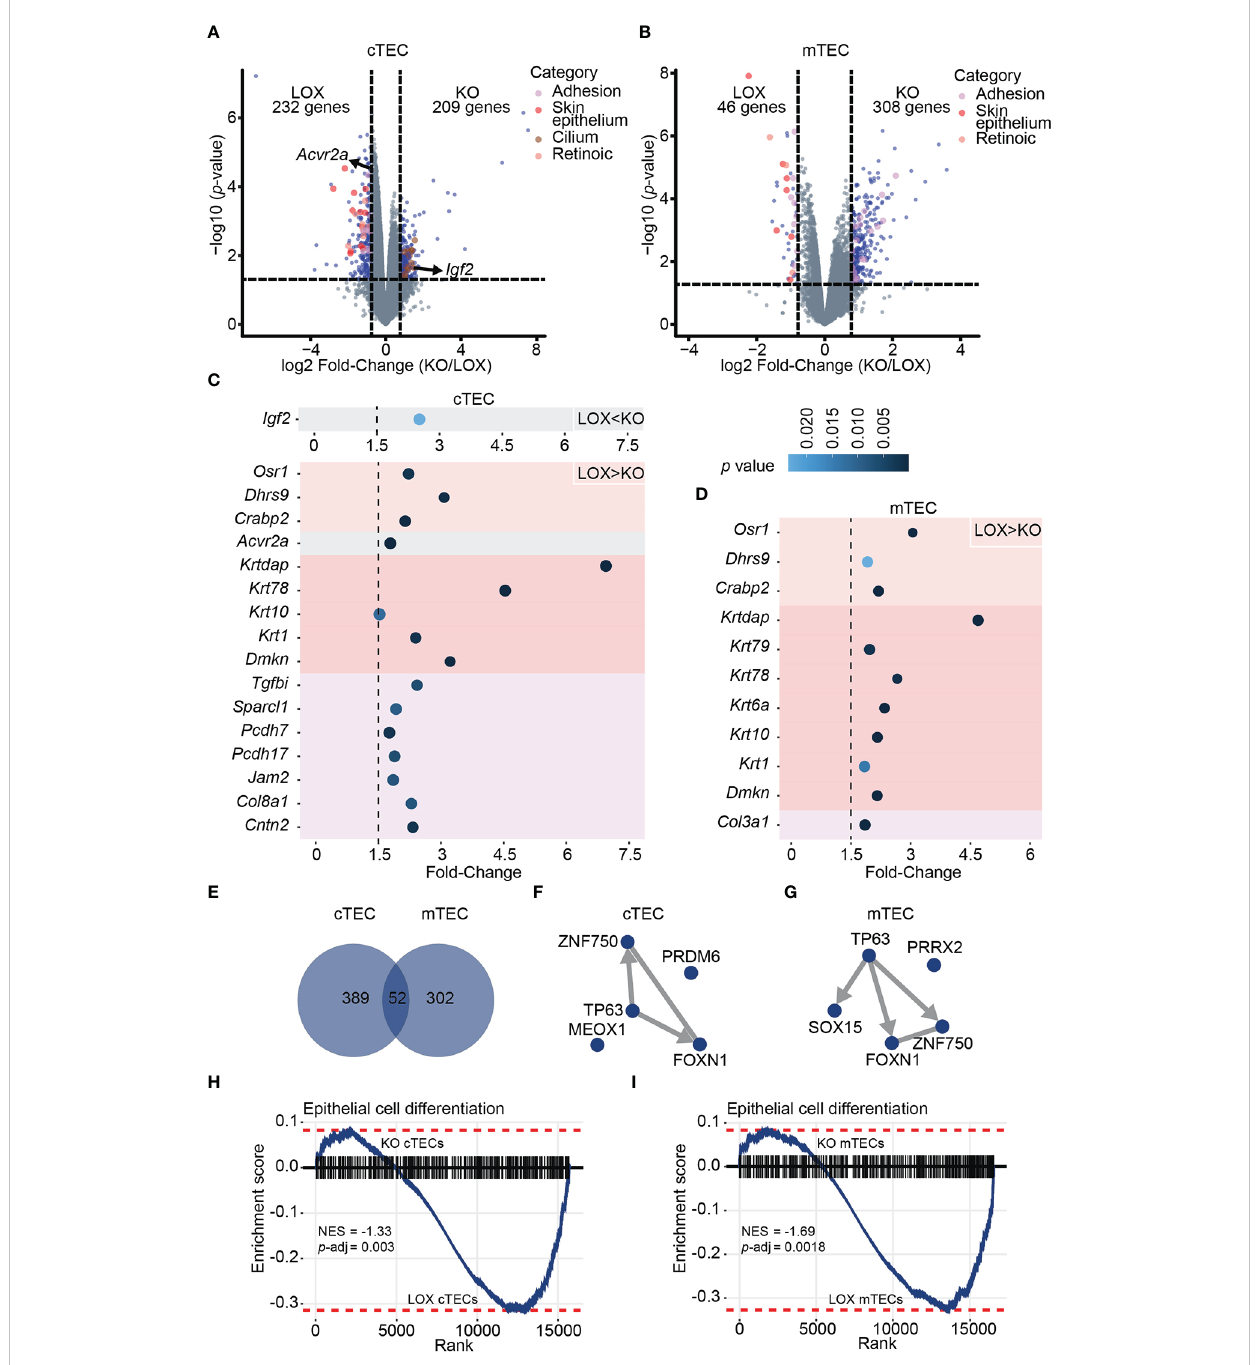
FIGURE 4 Klf4 deletion leads to a cell-type-speci fi c downregulation of terminal differentiation markers in TECs from non-pregnant females. (A, B) Volcano plots depicting differential gene expression in cTECs (A) and mTECs (B) between LOX and KO non-pregnant females. Colored dots represent DEGs with a p -value< 0.05 and a fold-change > 1.5. (C, D) Fold-Change of selected DEGs in cTECs (C) and mTECs (D) between LOX and KO females. The color circle gradient correlates with the p -value. (E) Venn diagram showing the overlap between DEGs identi fi ed in cTECs and mTECs of non- pregnant females. (F, G) TF-TF co-regulatory networks depict the interaction between TFs with the highest enrichment score based on the genes differentially expressed in cTECs (F) and mTECs (G) of LOX versus KO non-pregnant females. Edges are directed when ChIP-seq evidence supports the interaction and are undirected in the case of co-occurrence or co-expression evidence only. (H, I) Gene Set Enrichment Analysis (GSEA) for epithelial cell differentiation markers in cTEC (H) and mTEC (I) from LOX versus KO non-pregnant females. NES, normalized enrichment score; p -adj, false discovery rate adjusted p